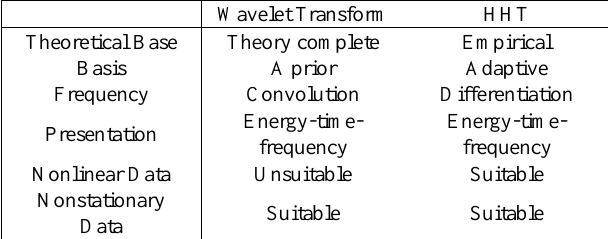
Table 1. Comparisons between Wavelet and Hilbert-Huang Transform (Huang, 2005)